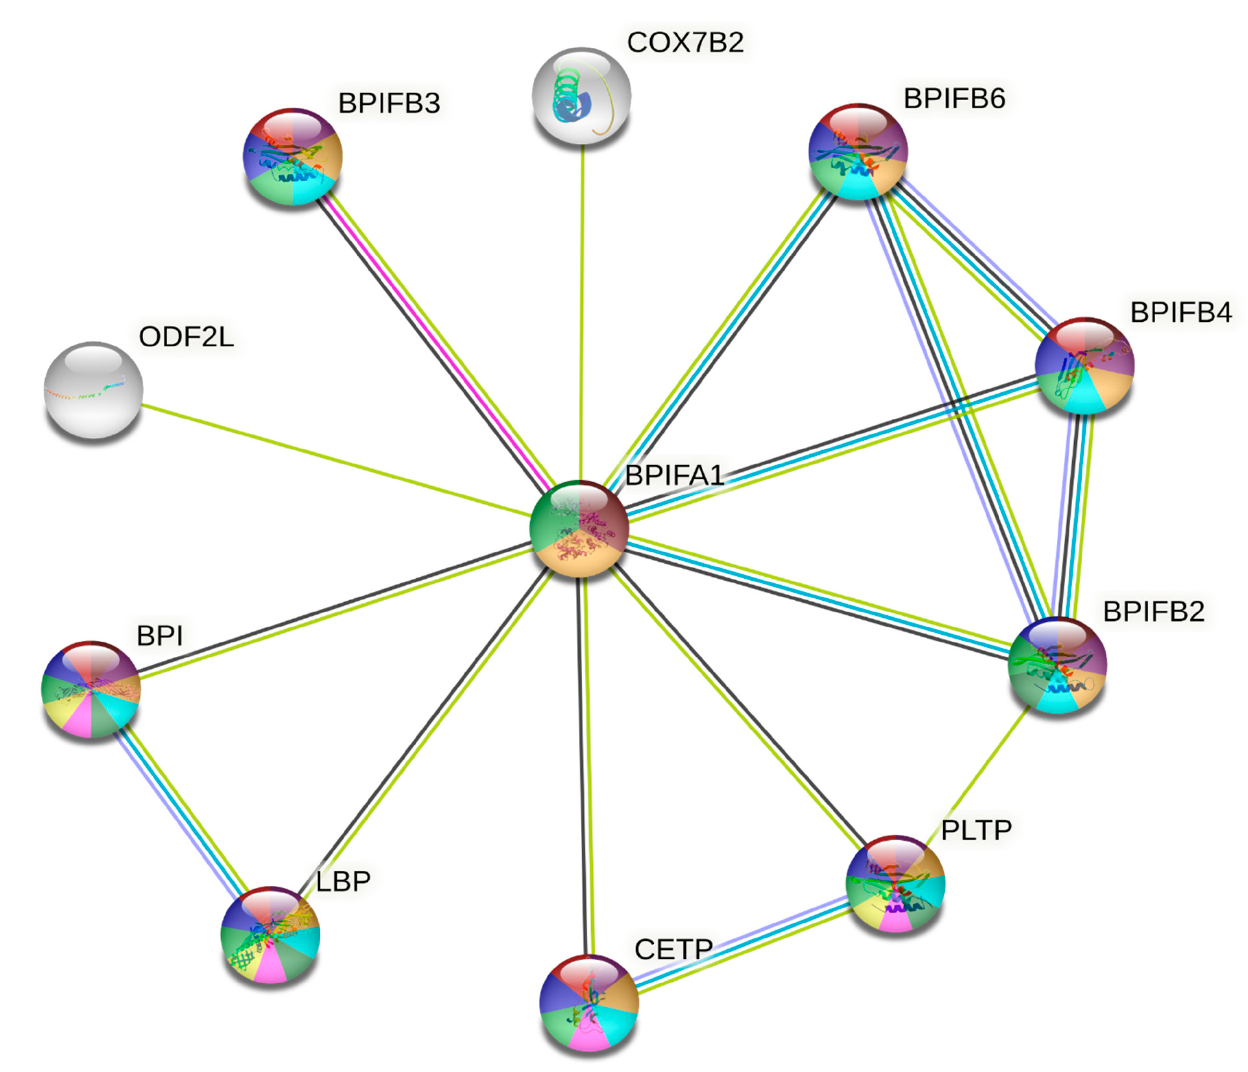
Figure 6. The protein-protein interaction (PPI) network for the BPIFA1 gene constructed using the online STRING database. The genes that are responsible for upregulation, downregulation, and neutral regulation are represented by red, blue, and green circles, respectively. The intensity of the interactions that take place between these genes is represented by the thickness of the lines that connect them. Mean values of a negative correlation coefficient are represented by solid edges, whereas mean values of a positive correlation coefficient are represented by dotted lines. Changes in the folding or stitching of proteins that take place after transcription are represented as nodes in the protein-protein interaction (PPI) network. Each node in the network represents the whole set of proteins that can be produced by a single copy of the protein-coding gene. Table 6. Functional enrichment of biological processes in the human BPIFA1 protein network.